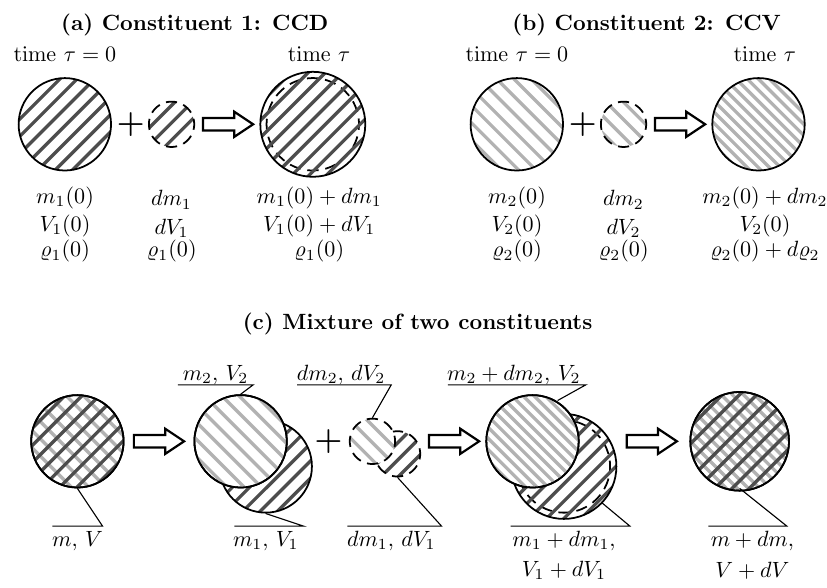
Figure 1. Illustration of different scenarios for adding mass to individual constituents and a mixture of two constituents. ( a ) Constituent 1, constant density (CCD): adding the mass dm 1 of the volume dV 1 to the initial mass m 1 ( 0 ) of the volume V 1 ( 0 ) results in increased mass m 1 + dm 1 and volume V 1 + dV 1 . However, the density (cid:36) 1 ( τ ) = (cid:36) 1 ( 0 ) remains constant; ( b ) Constituent 2, constant volume (CCV): adding the mass dm 2 of the density (cid:36) 2 ( τ ) = (cid:36) 2 ( 0 ) to the initial mass m 2 ( 0 ) of density (cid:36) 2 ( 0 ) results in increased mass m 2 + dm 2 but unchanged volume V 2 ( τ ) = V 2 ( 0 ) . Hence, the density (cid:36) 2 ( τ ) = (cid:36) 2 ( 0 ) + d (cid:36) 2 increases; ( c ) Mixture of Constituent 1 (following CCD) and Constituent 2 (following CCV): The tissue of mass m and volume V is composed of Constituent 1 ( m 1 , V 1 ) and Constituent 2 ( m 2 , V 2 ). The mass increments dm 1 , dm 2 of volumes dV 1 , dV 2 are added to each constituent. This results in increased masses of both constituents, increased volume of Constituent 1 and unchanged volume of Constituent 2. Over all the mass m + dm and the volume V + dV of the mixture have been